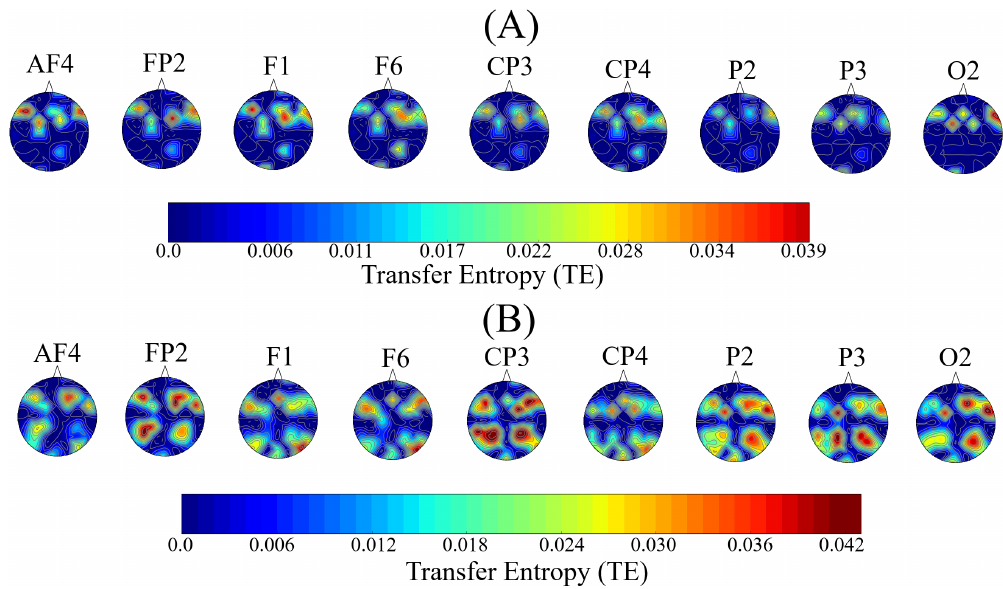
Figure 5. Eyes-Closed (EC) setting. Global distribution of TEs of channels whose total TE values significantly differed between HIGH and LOW stress-susceptible groups. These channels were FP2, AF4, F1, F6, CP3, CP4, P2, P3, and O2. ( A ) HIGH stress-susceptible group ( B ) LOW stress-susceptible group. This figure indicates that distributed TEs from these channels were primarily contributed to the frontal regions in the case of HIGH stress-susceptible group. On the other hand, their contribution was more globally distributed among fronto-parietal in the case of LOW stress-susceptible